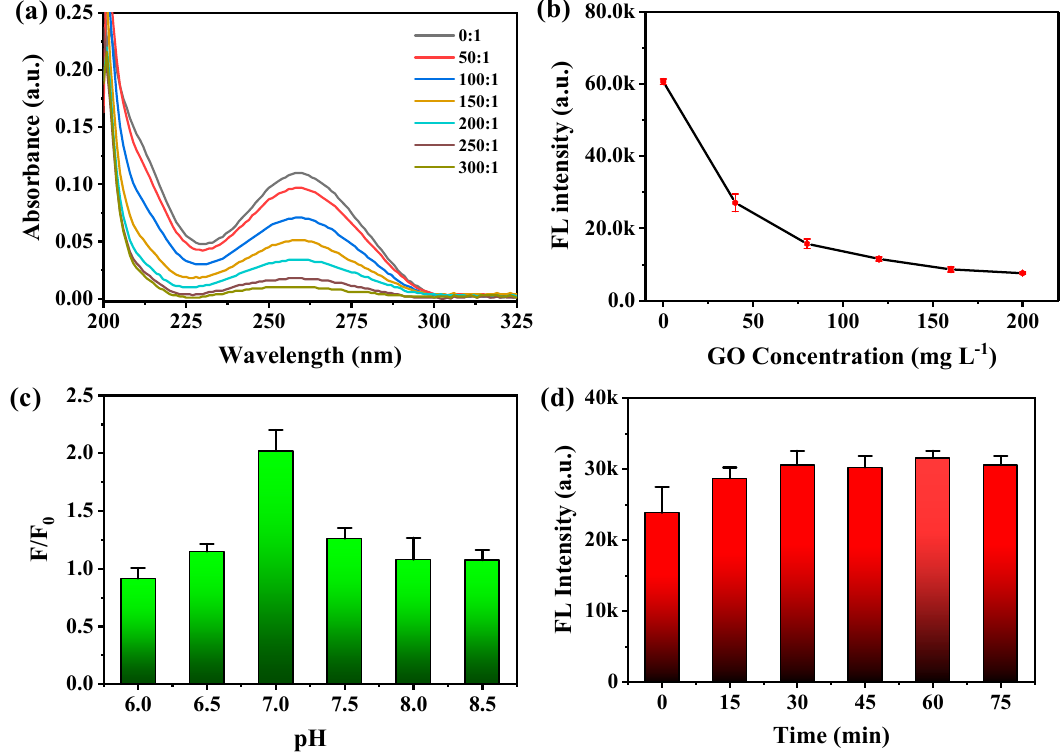
Figure 5. Optimization of experimental conditions. ( a ) UV-vis spectra of the aptamers supernatant after 30 min incubation at different ZGO:0.5%Mn/aptamer mass ratios of 0:1, 50:1, 100:1, 150:1, 200:1, 250:1, and 300:1 (wt%). ( b ) Effect of GO concentration on the luminescence intensity of ZGO:0.5%Mn- aptamer. ( c ) The F/F 0 value change of the aptamer-loaded ZGO:0.5%Mn at different pH (F 0 and F, represents the luminescence intensity of the nanoprobe in the absence and presence of adenosine, respectively.) ( d ) Effect of As(III) incubation time on luminescence intensity of ZGO:0.5%Mn- aptamer.